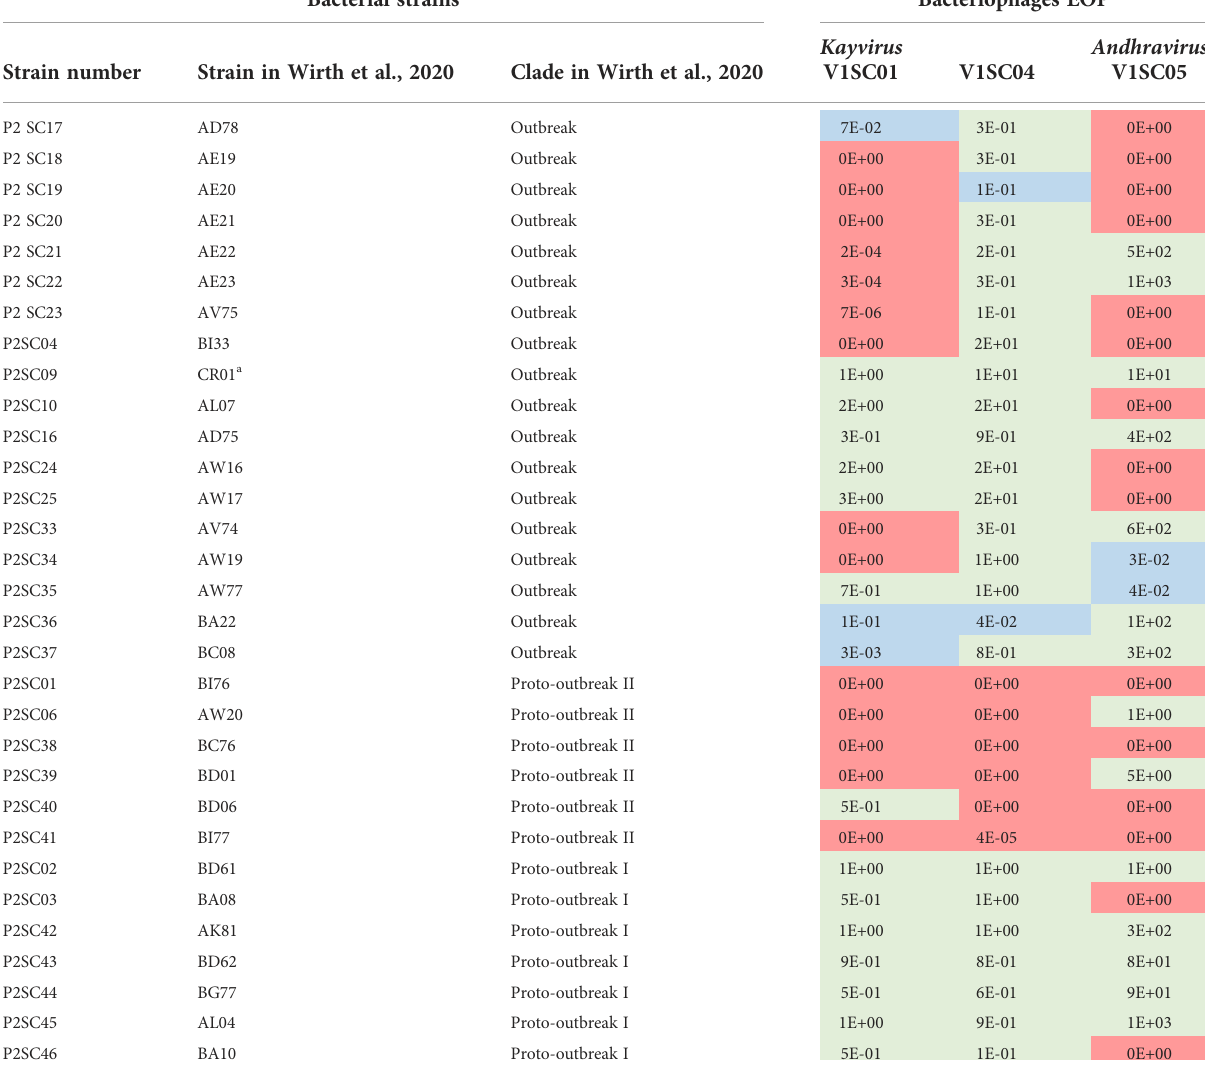
TABLE 1 Host range characterization of fi ve anti-Staphylococcus capitis